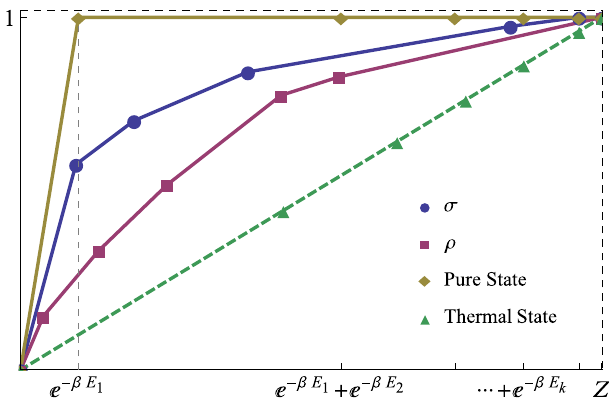
FIG. 4. We show the β -ordered thermomajorization diagrams for various states of the system. Note that different states may have different β -orderings, and the markings on the x axis correspond to one particular β -ordering. The curves always end at ð Z; 1 Þ . The thermomajorization criteria states that we can take a state to another under thermal operations if and only if the curve of the initial state is above that of the final state. Hence, in this case (provided ρ is block diagonal in the energy eigenbasis) there is a set of operations such that σ ! TO ρ , but not for the reverse